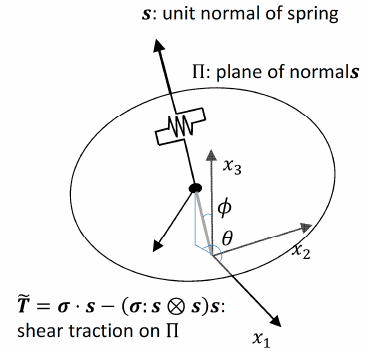
Figure 3. Schematic view of the proposed model.